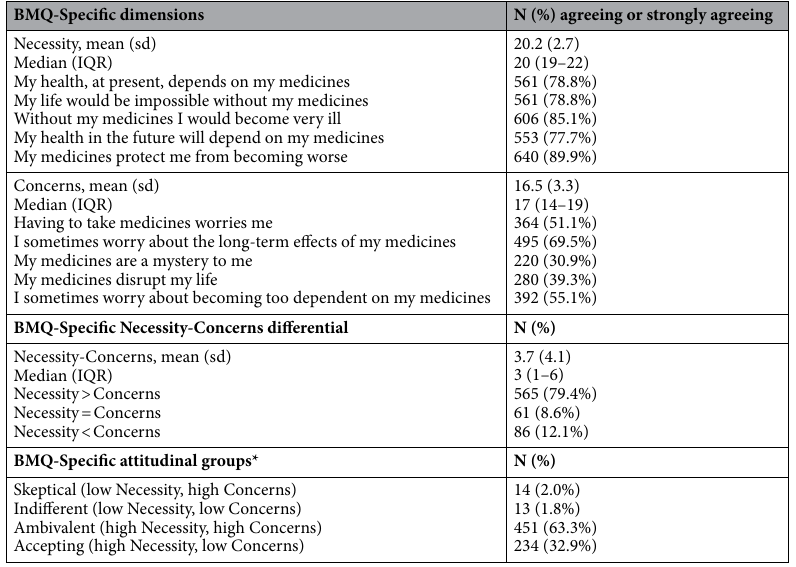
Table 2. Beliefs about Medicines Questionnaire (BMQ)-Specific dimensions (n = 712). *Necessity and Concerns dimensions were divided at the scale midpoint 15 (low Concerns ≤ 15, high Concerns > 15; low Necessity ≤ 15, high Necessity > 15).